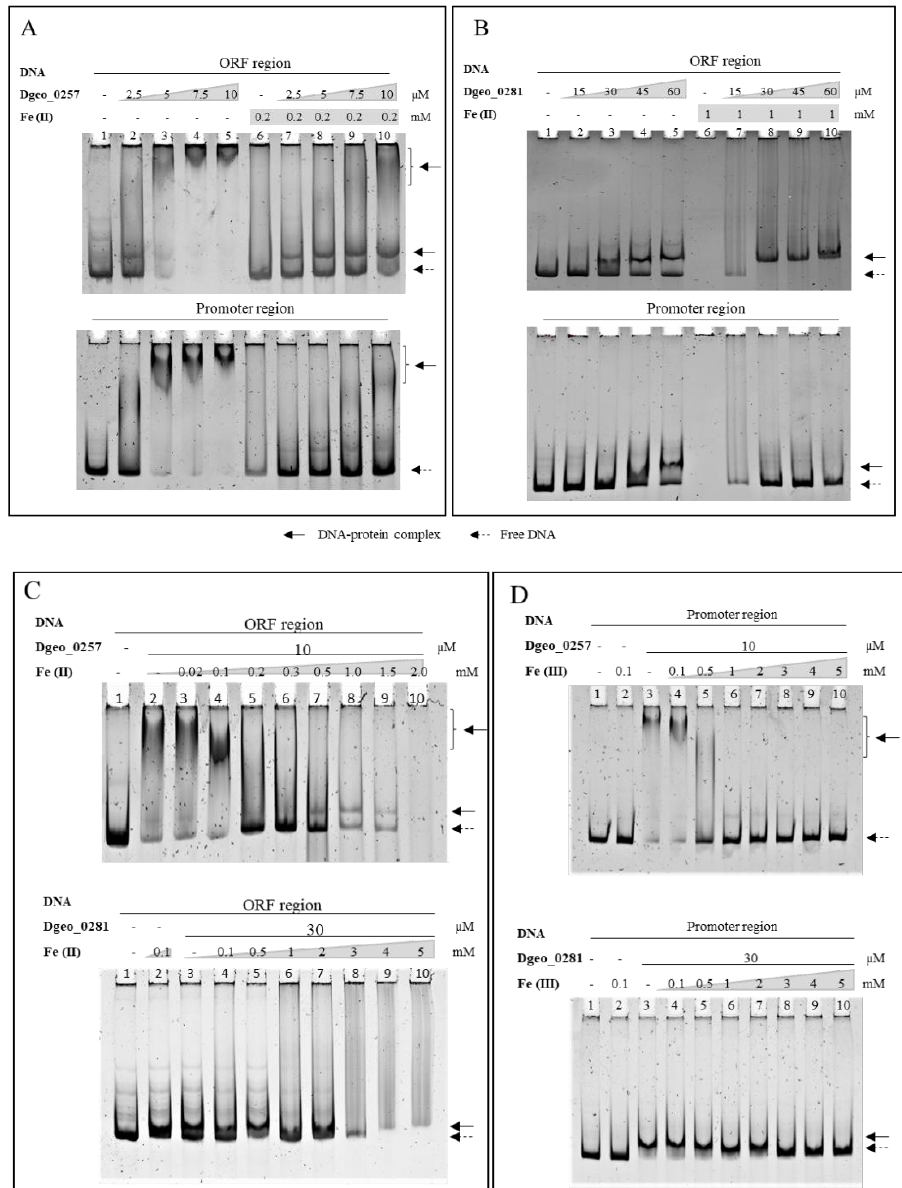
Figure 2. EMSA of Dgeo_0257 ( A ) and DgDps1 ( B ) on both promoter and ORF regions with increasing protein concentration. Dgeo_0257 and DgDps1 were treated with 0.2 mM and 1.0 mM ferrous ion concentration at lanes 6 – 10, respectively. Lane 1, free DNA; lanes 2 – 5, increased amounts of purified Dgeo_0257 and DgDps1 proteins (2.5 – 10 µM and 15 – 60 µM, respectively). Comparison of differential concentrations of ferrous ions ( C ) and ferric ions ( D ) on ORF and promoter regions, respectively.